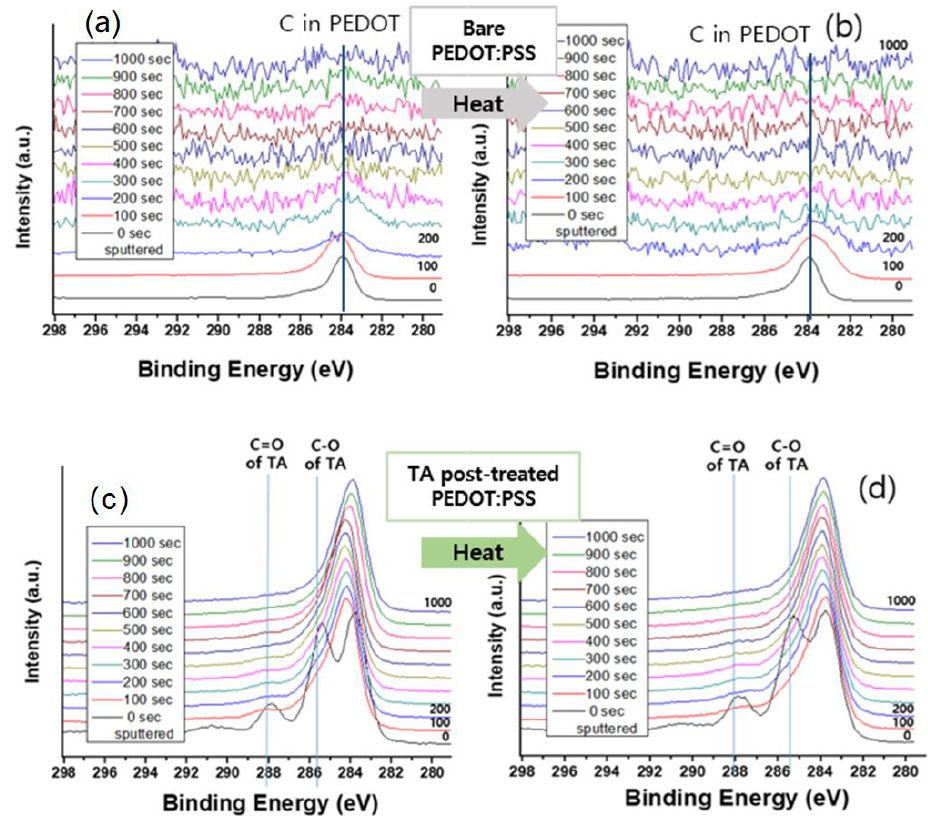
Figure 4. C1s XPS spectra of ( a ) PEDOT:PSS, ( b ) PEDOT:PSS-HT, ( c ) TA-dipped PEDOT:PSS, and ( d ) TA-dipped PEDOT:PSS-HT films. The legends indicate the time since the start of the depth profiling. Zero is equivalent to a standard surface scan.